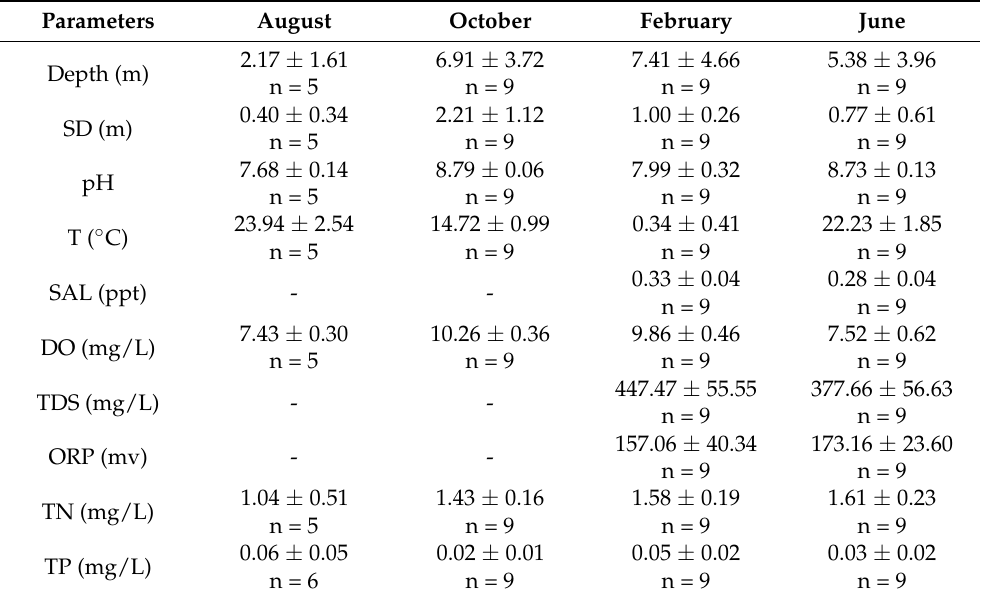
Table 1. Physio-chemical characteristics (mean ± SD) in the Kizil Reservoir a . Parameters